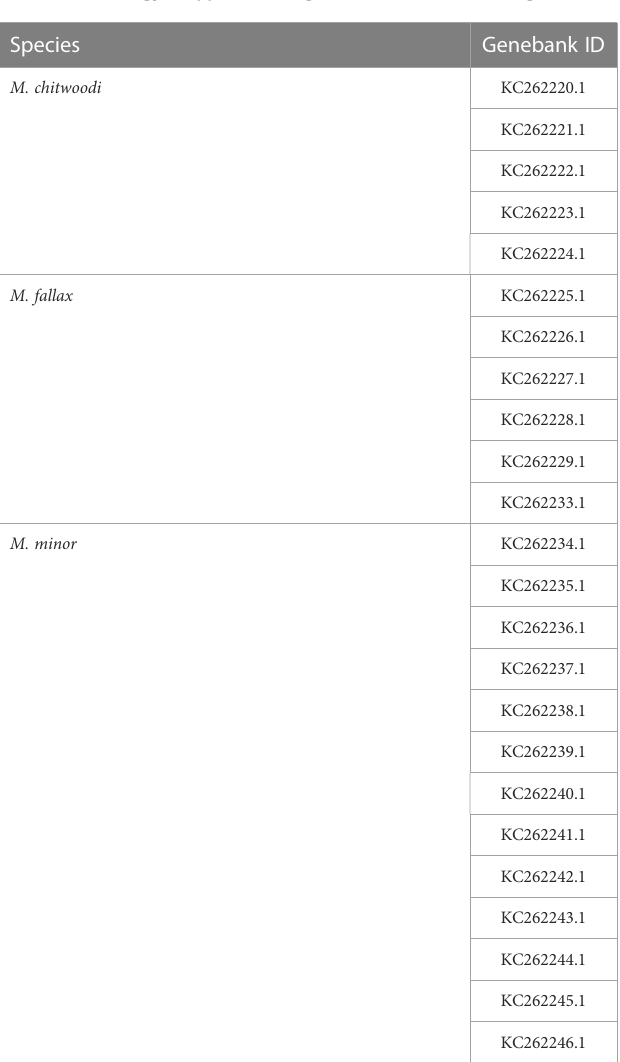
TABLE 1 Meloidogyne spp. HSP90 regions used for beacon